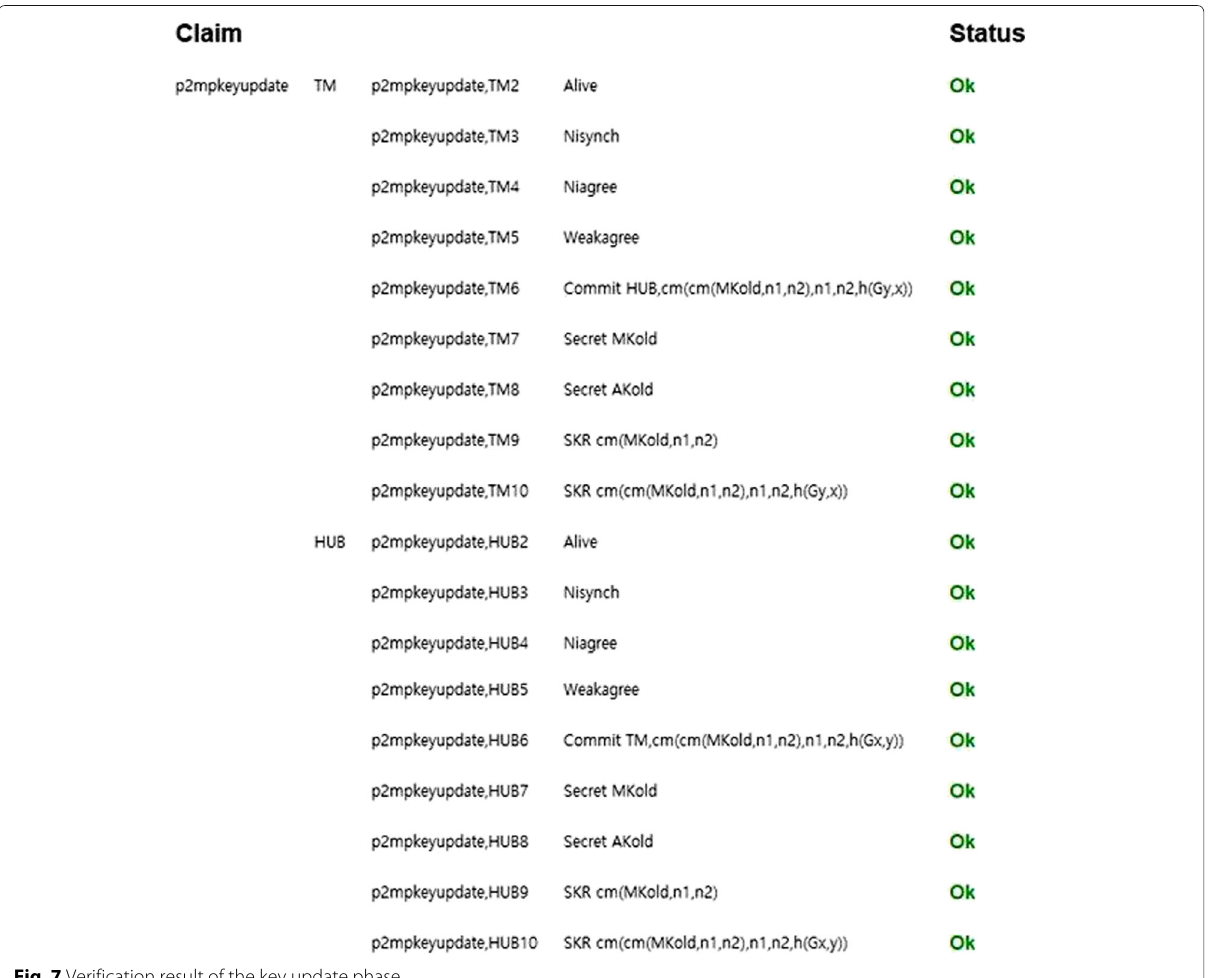
Fig. 7 Verification result of the key update phase